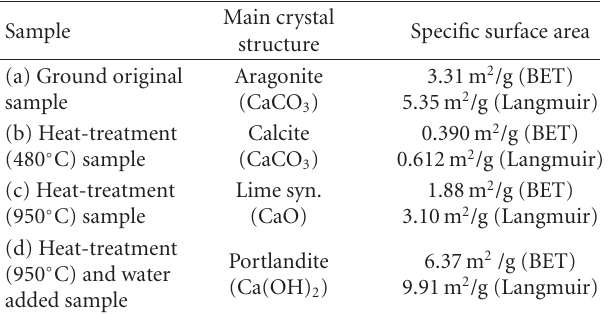
Table 2: The crystal structures and the specific surface areas of four kinds of sieved Buccinum tenuissimum shell biomass.